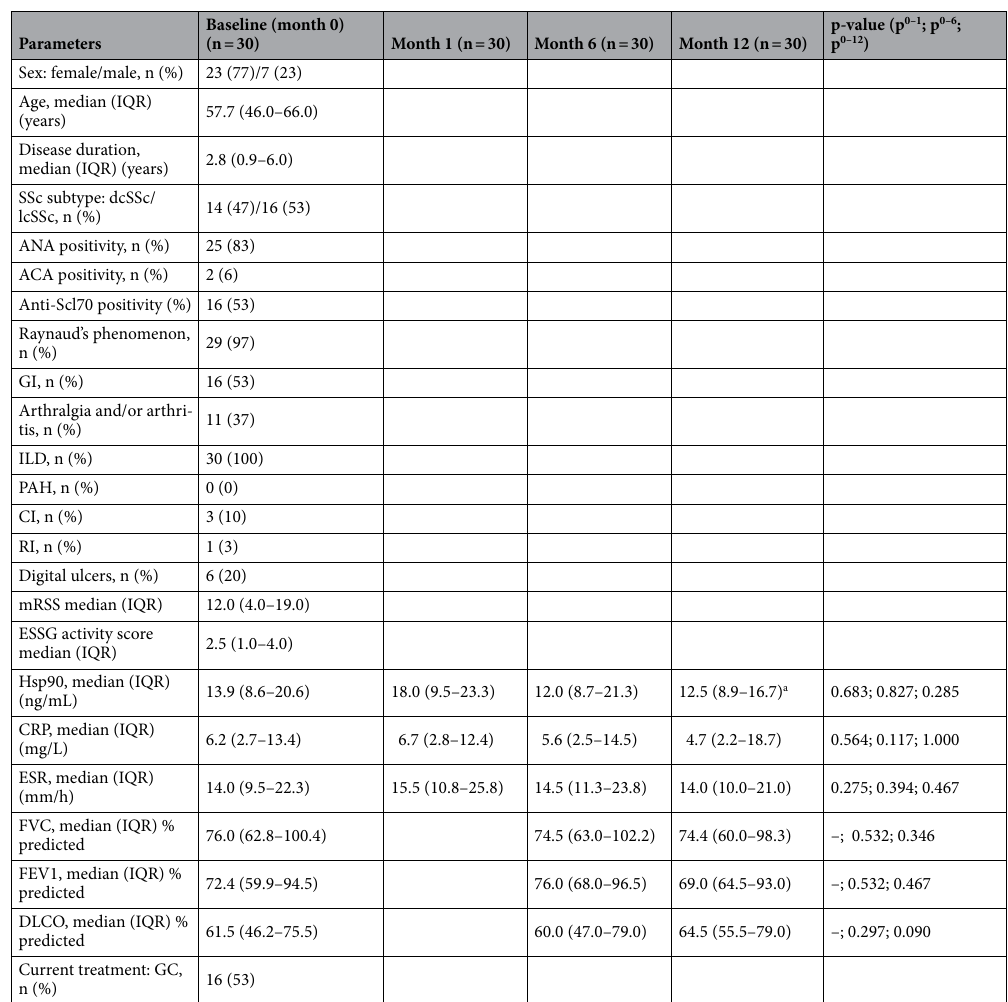
Table 2. Baseline clinical parameters of patients with SSc-ILD treated with cyclophosphamide: longitudinal analysis. SSc systemic sclerosis, lcSSc limited cutaneous SSc, dcSSc diffuse cutaneous SSc, IQR interquartile range, ANA antinuclear antibodies, Anti-Scl-70 anti–DNA-topoisomerase I antibodies, ACA anticentromere antibodies, GI gastrointerstinal ivolvement, ILD interstitial lung disease, PAH pulmonary arterial hypertension, CI cardiac involvement, RI renal involvement, ESSG European Scleroderma Study Group, mRSS modified Rodnan skin score, CRP C-reactive protein, ESR erythrocyte sedimentation rate, FVC forced vital capacity, FEV1 forced expiratory volume in one second, DLCO diffusing capacity for carbon monoxide, GC low dose glucocorticoids (i.e. ≤ 10 mg/day of prednisone), p 0–1 difference between month 0 and 1, p 0–6 difference between month 0 and 6, p 0–12 difference between month 0 and 12 tested by Friedman’s test (for all comparisons). a Values for plasma Hsp90 at month 12 are available only for 14 patients who underwent a 12-month cyclophosphamide